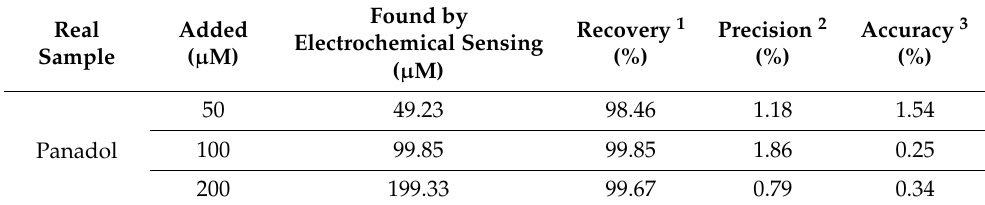
Figure 9. Real sample analysis (commercial Panadol (500 mg/tablet)) of Ni–Co–Te/Nafion-modified GCE using DPV in 0.1 M PBS (pH = 7.0) with the addition of various acetaminophen concentrations (50, 100, and 200 µ M). Table 3. Real sample analysis of Ni–Co–Te